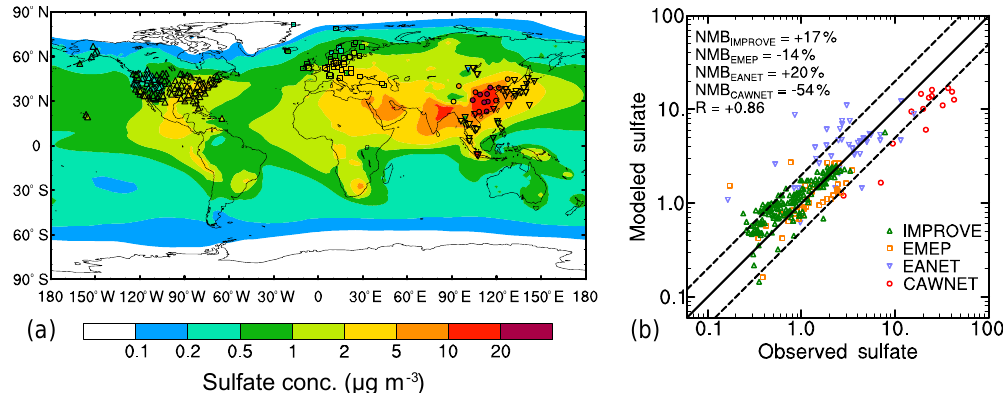
Figure 2. Spatial distribution (left panel) and scatter plot (right) between the simulated and observed annual mean near-surface sulfate concentrations (µgm − 3 ) over years 2010–2014. Observations are from IMPROVE (upward-pointing triangle), EMEP (square), EANET (downward-pointing triangle) for years 2010–2014 and CAWNET (circle) for years 2006–2007, which are scaled to 2010–2014 based on the ratio of CEDS 2010–2014 SO 2 emissions to 2006–2007 emissions over China (0.92). Solid lines mark the 1 : 1 ratio and dashed lines mark the 1 : 2 and 2 : 1 ratios. Normalized mean bias (NMB) and correlation coefficient ( R ) between observation and simulation are shown on the right panel. NMB = 100% × P (M i − O i )/ P O i , where M i and O i are the modeled and observed values at site i ,